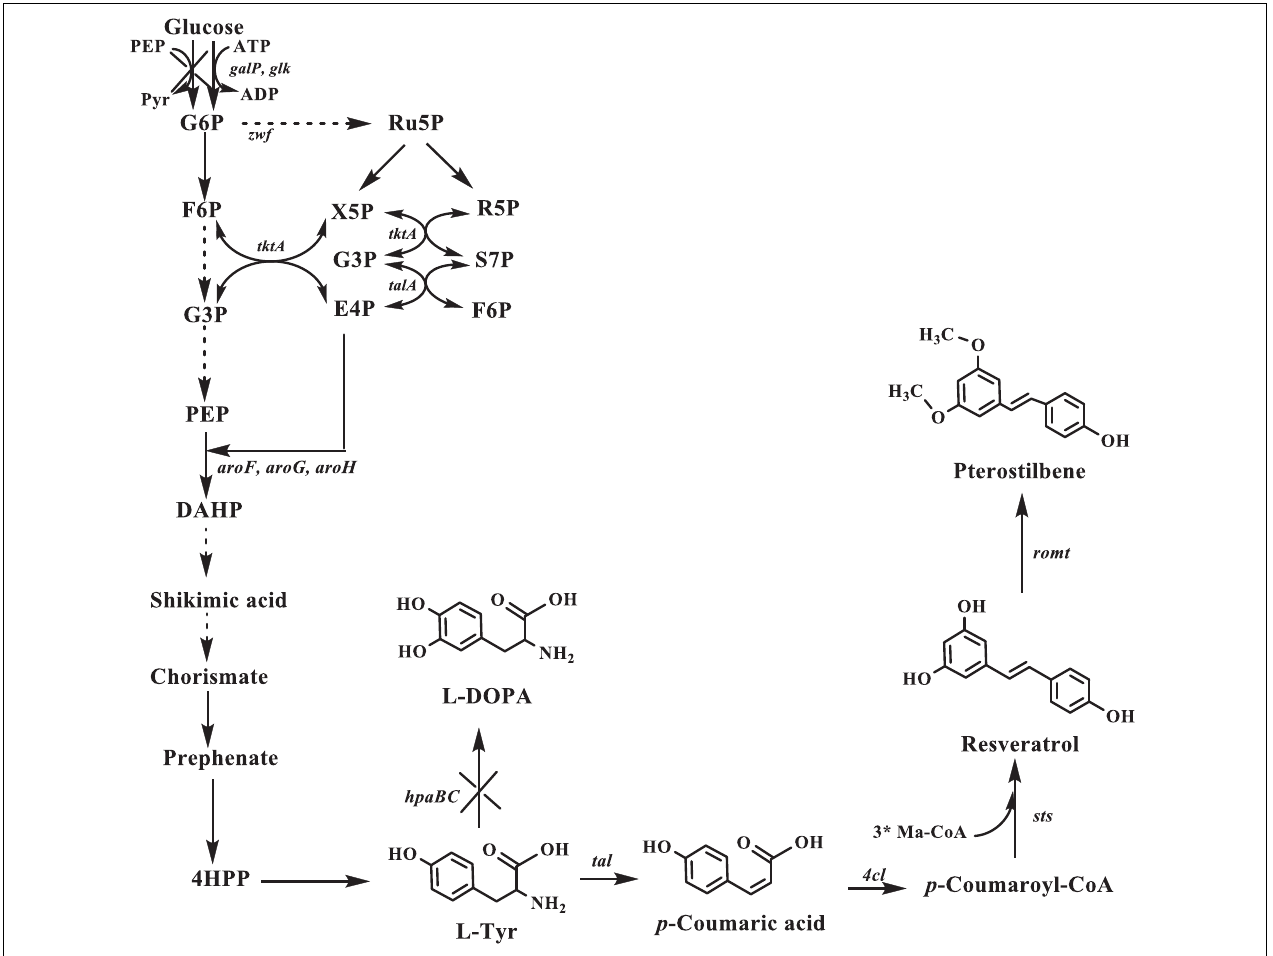
FIGURE 1 | Pterostilbene biosynthetic pathway in Escherichia coli . The × ’s indicate that the gene is deleted. G6P, glucose 6-phosphate; F6P, fructose-6-phosphate; G3P, glyceraldehde-3-phosphate; Ru5P, ribulose-5-phosphate; X5P: xylulose-5-phosphate; R5P, ribose-5-phosphate; S7P, sedoheptulose-7-phosphate; PEP, phosphoenolpyruvate; E4P, D-erythrose-4-phosphate; DAHP, 3-deoxy-D-arabino-heptulosonate-7-phosphate; L-Tyr, L-tyrosine; L-DOPA: L-3,4-dihydroxyphenylalanine; galP , galactose permease gene; glk , glucokinase gene; zwf , glucose-6-phosphate dehydrogenase gene; tktA , transketolase 1 gene; talA , transaldolase A gene; aroF , aroG , aroH , DAHP synthase gene; hpaBC , p-hydroxyphenylacetate 3-hydroxylase gene; tal , tyrosine ammonia-lyase gene; 4cl , 4-coumarate:CoA ligase gene; sts , stilbene synthase gene; romt , resveratrol O-methyltransferase